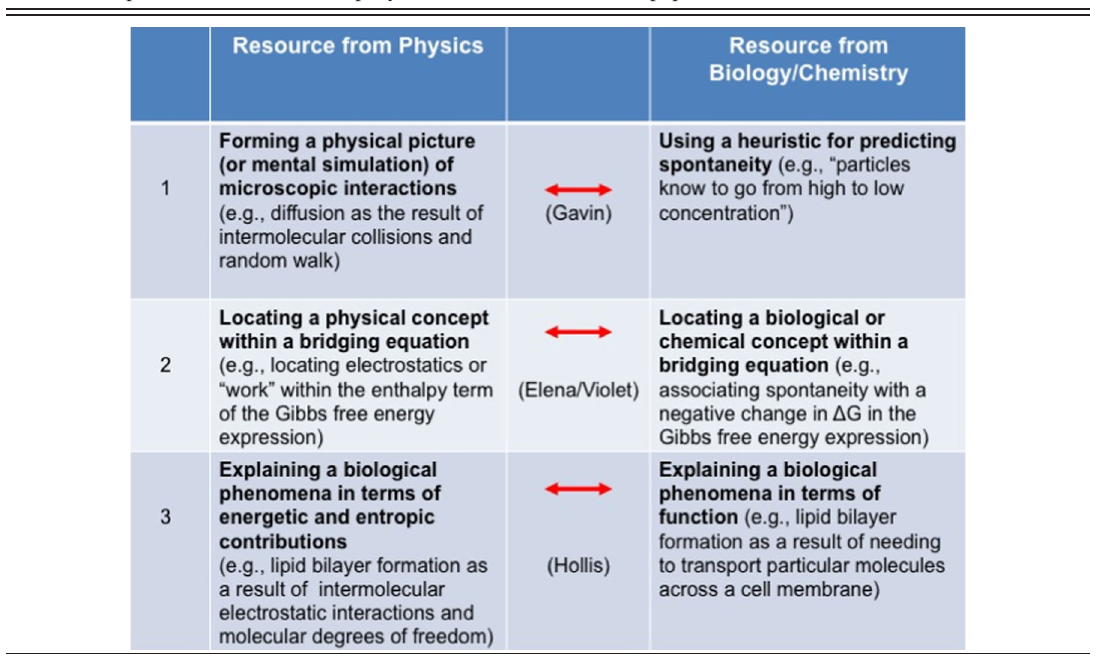
TABLE I. Student resources for forming interdisciplinary connections in IPLS are organized into three complementary classes. Each class is a row in the table. The names in parentheses refer to the case study students whose examples were used to exemplify the classes earlier in the